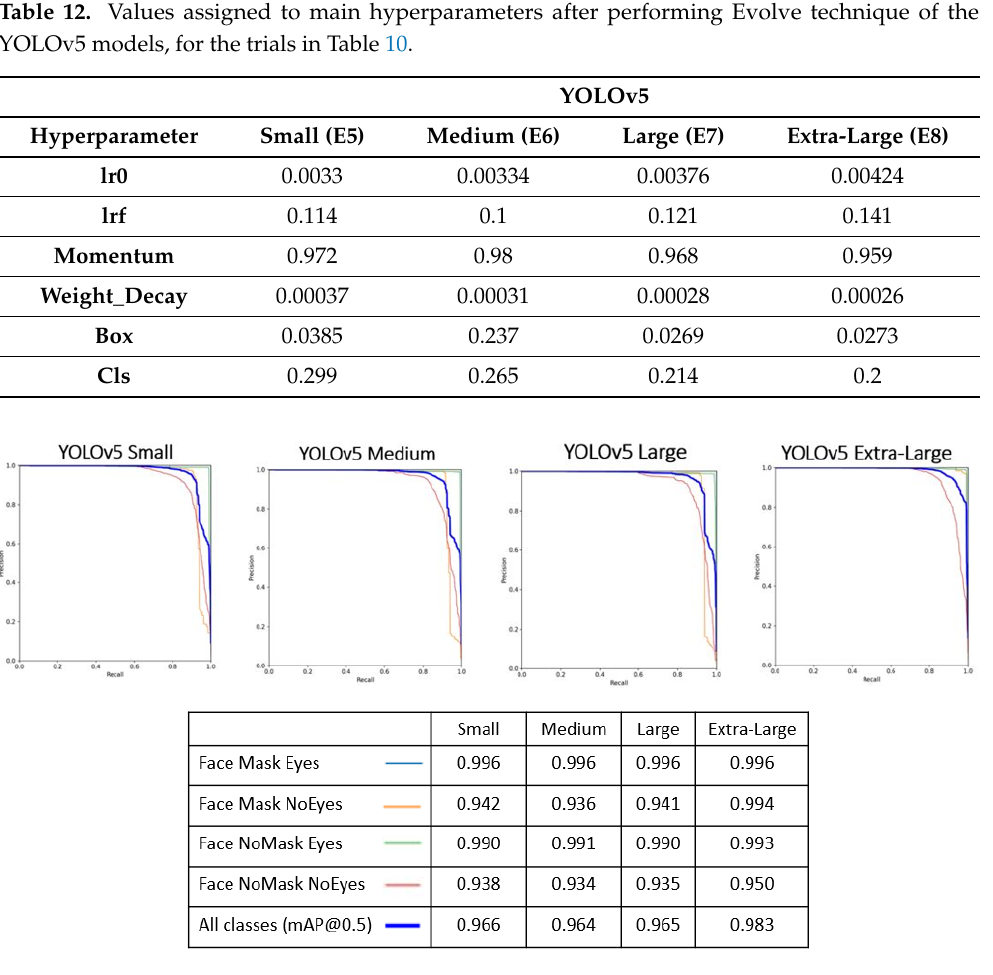
Figure 10. Presentation of Precision-Recall curves of models. In the legend of each model, you can see average accuracies obtained for each